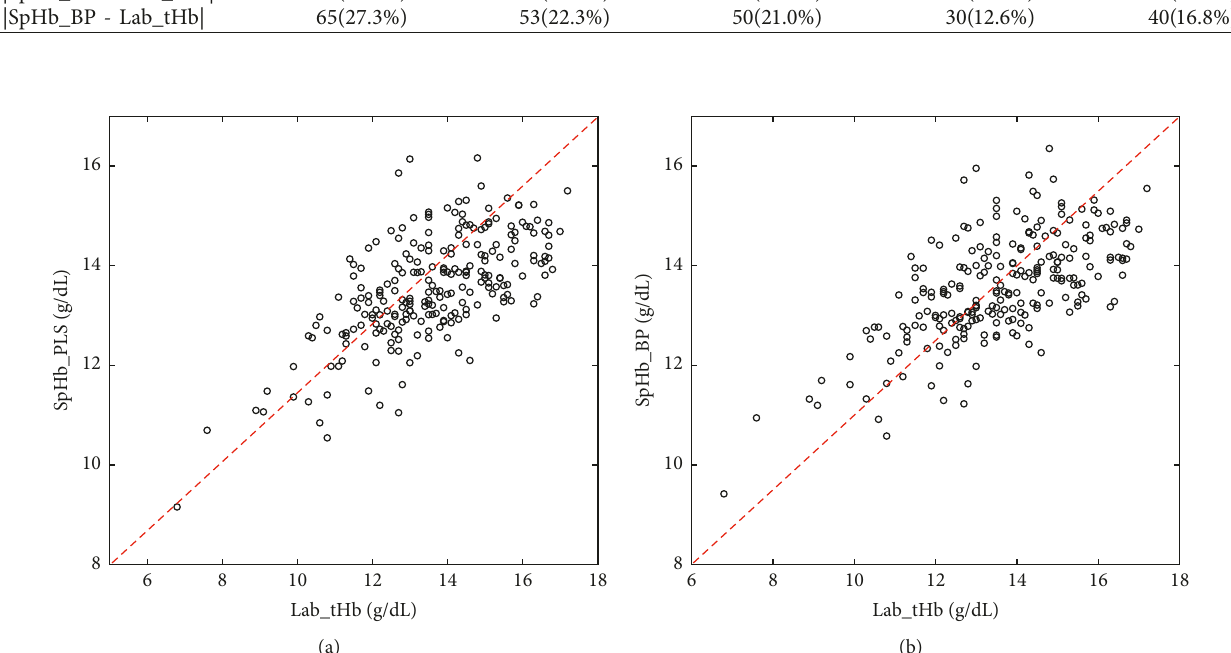
Figure 4: Scatter plot of invasive tHb values vs. noninvasive SpHb measurements. (a) Lab_tHb vs. SpHb_PLS and (b) Lab_tHb vs. SpHb_BP.